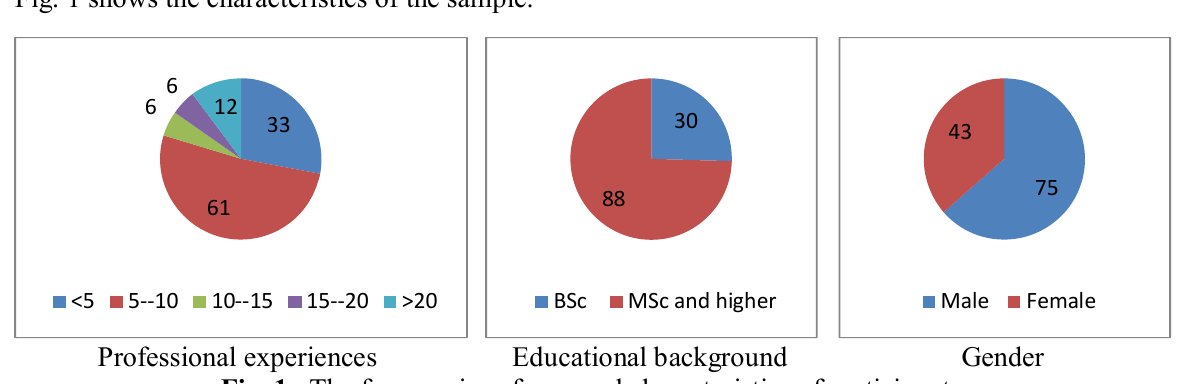
Fig. 1. The frequencies of personal characteristics of